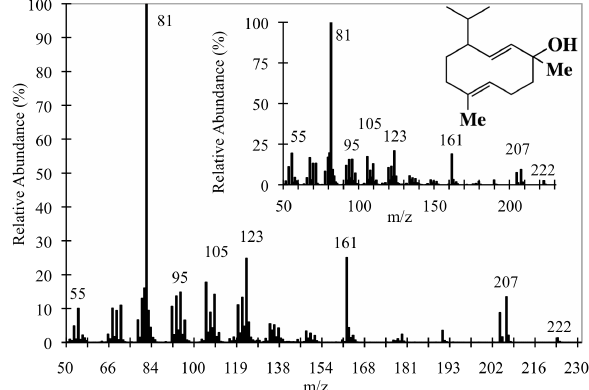
Fig. 2. Mass spectrum of germacrene D-4-ol from a field sample and from the NIST mass spectral library (embedded) with a pro- posed